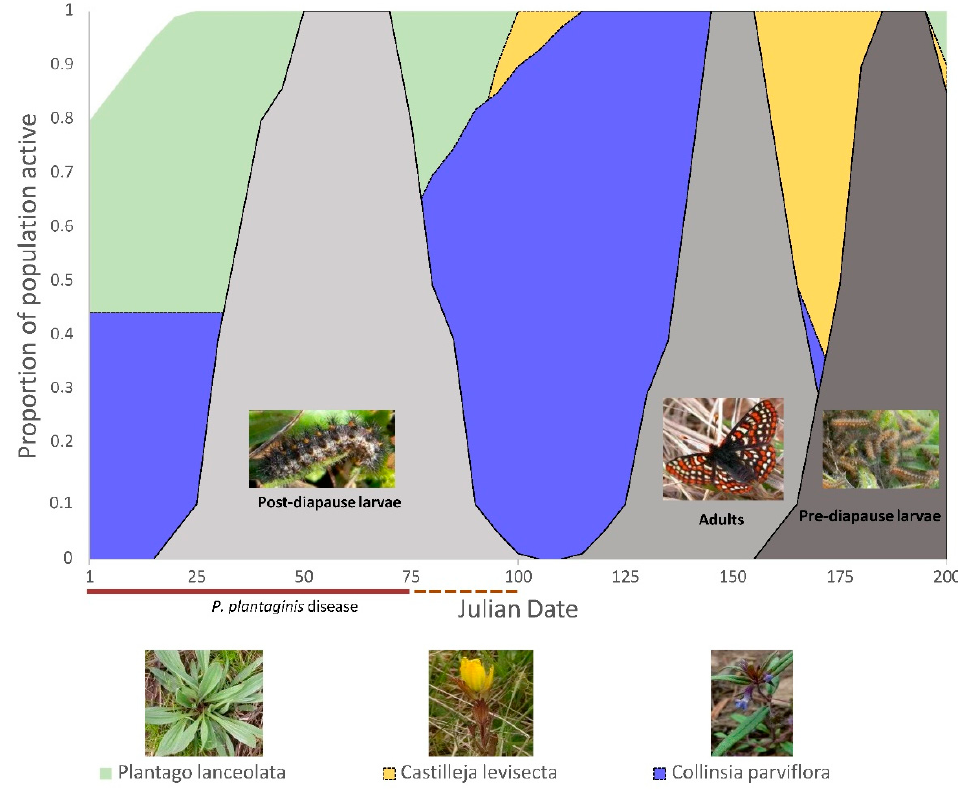
Figure 3. Temporal profiles of plantain-dependent Taylor’s checkerspot butterfly development and host plant availability arranged by Julian date in Washington, USA populations. Relative abundance of butterflies (gray shaded areas) and host plants (green = Plantago lanceolate —plantain, blue = Collinsia parviflora , yellow = Castilleja levisecta ) are represented as the proportion of the total observed for that life stage (butterflies) or monitored plant populations. P. plantaginis disease occurrence is indicated by the bar below the x -axis where the time period with the most severe disease (>50% of diseased plants with >50% foliar necrosis) is represented by a solid brown line and a dotted brown line represents the transition period from severe disease (>50% necrosis covering the entire leaf crown of infected plants) to no disease.